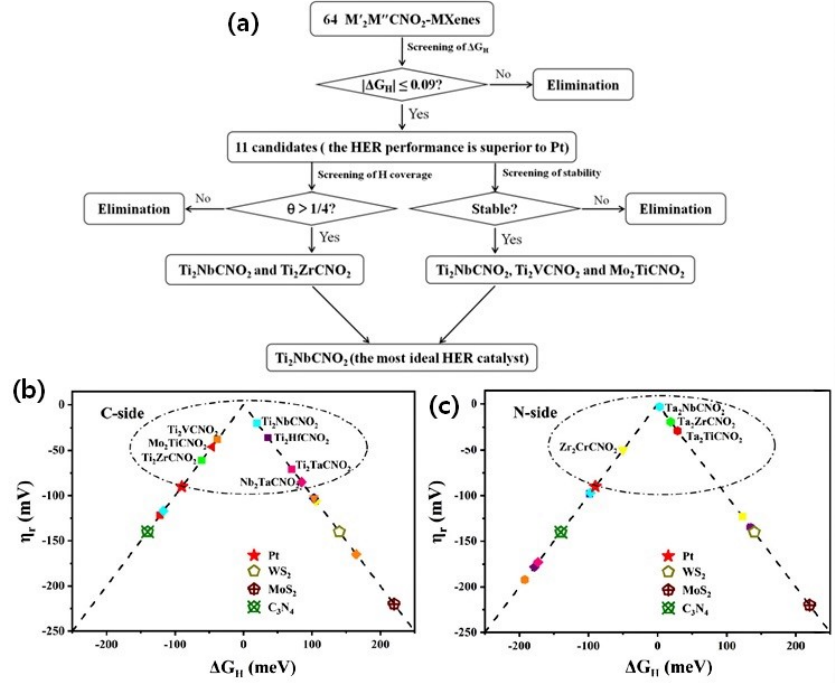
Figure 5. ( a ) Screening workflow. The screening process of HER catalysts from 64 M ′ 2 M ″ CNO 2 - MXenes. The volcano plotted for all 64 M ′ 2M ″ CNO 2 -MXenes of ( b ) C side ( c ) N side. The different shapes represent different M ′ , and different colors represent different M ″ (red, orange, yellow, green, cyan, blue, purple and pink represent Ti, V, Cr, Zr, Nb, Mo, Hf and Ta, respectively). Adapted from Ref. [71], (Open Access).